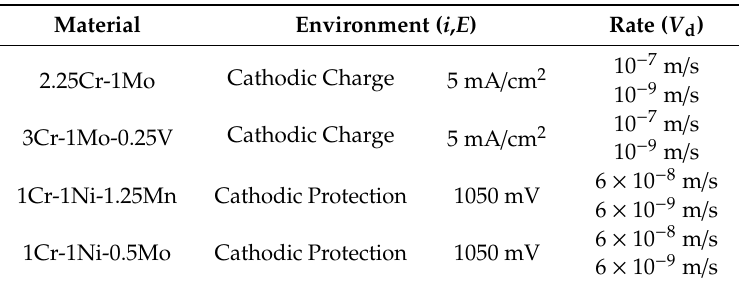
Table 2. Test plan carried